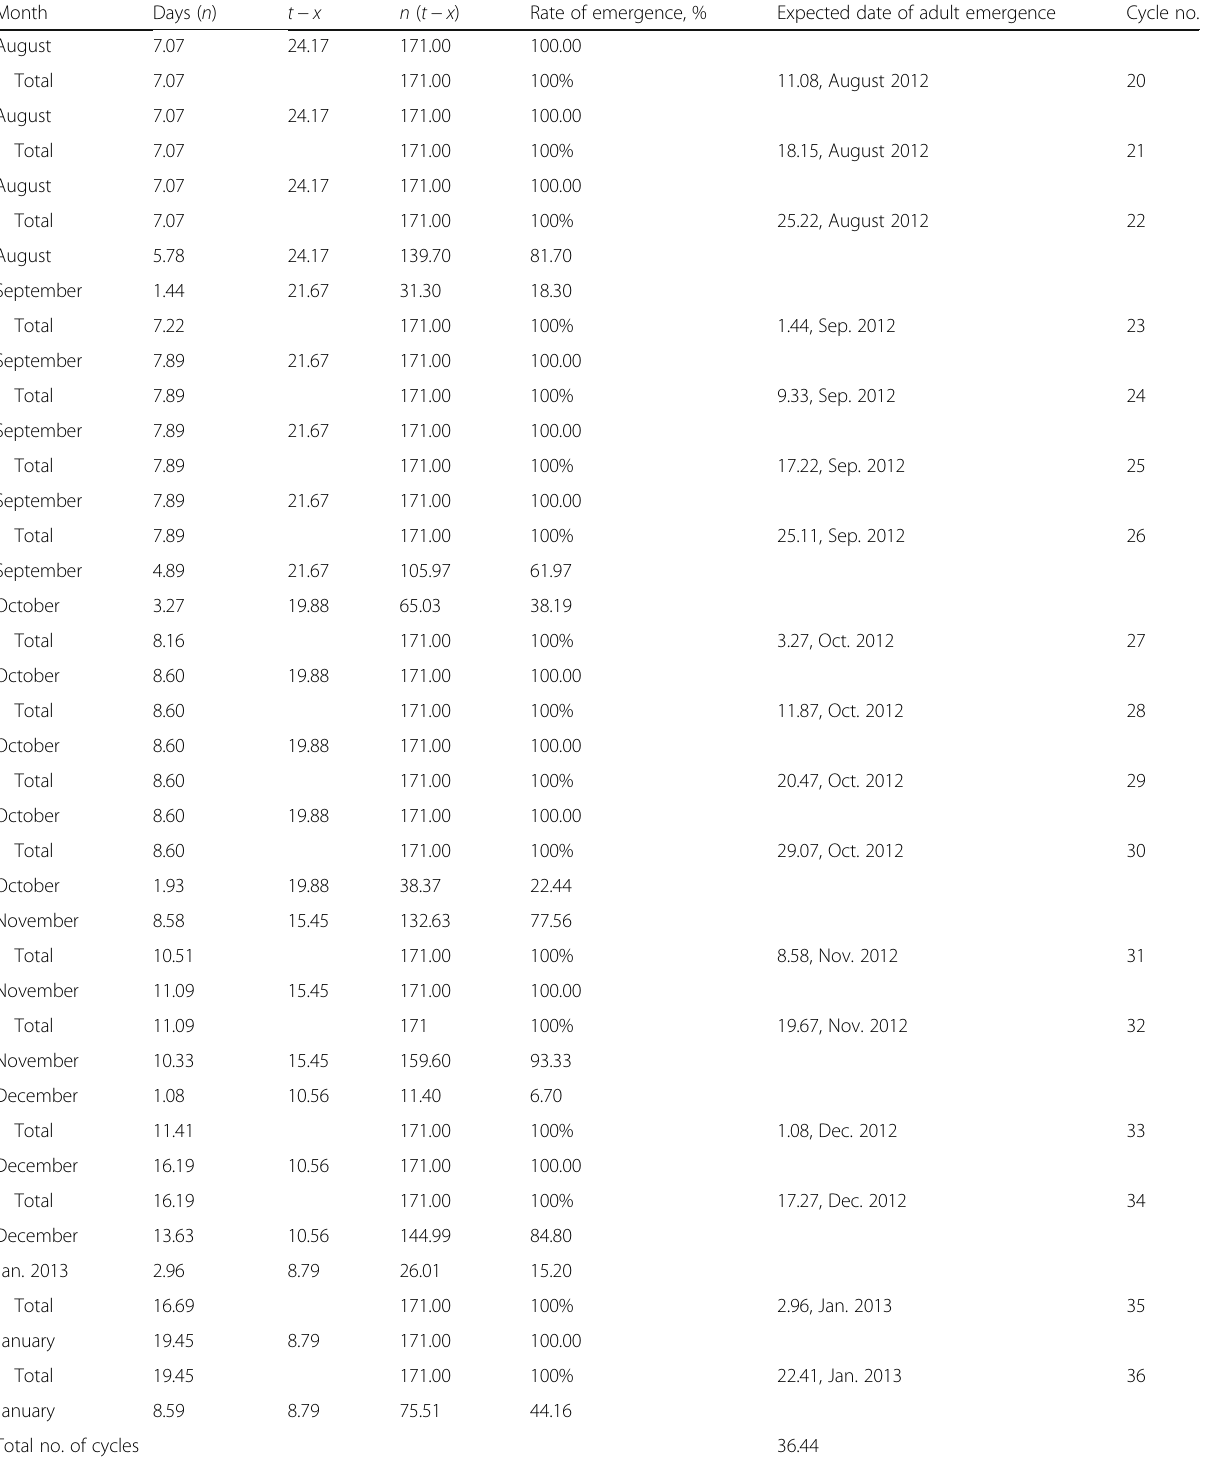
Table 1 Expected frequencies of emergence of Tuta absoluta moths in the Egyptian fields (Continued) Month Days ( n ) Rate of emergence,